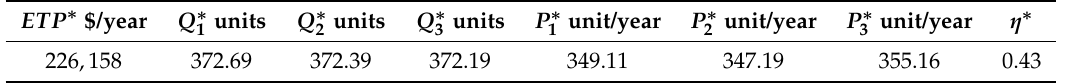
Table 5. The optimal values of Example 2.